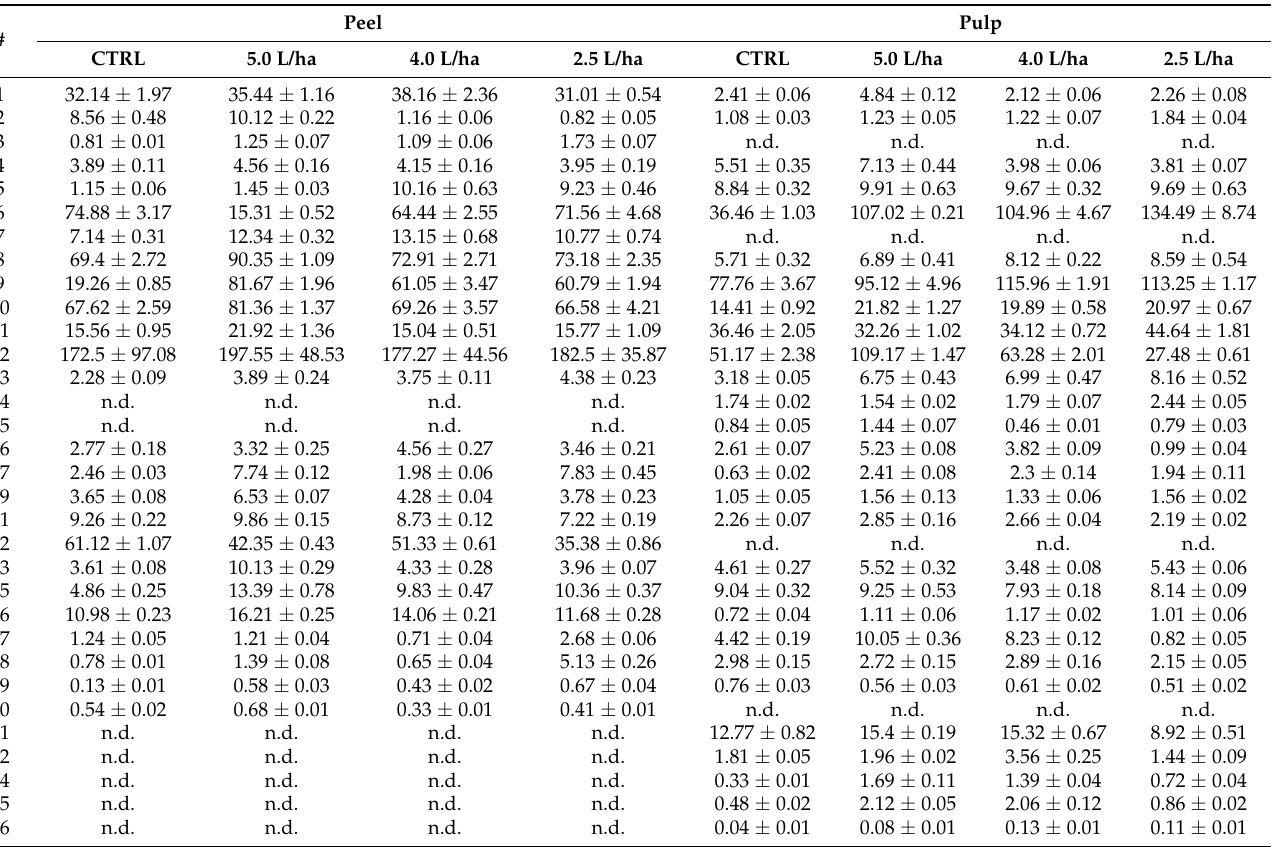
Table 3. Quantitative analysis of polyphenols identified in the fruit peel and pulp of the “West Rose” variety harvested from Prunus persica trees after treatment with three different concentrations of biostimulant (5.0, 4.0 or 2.5 L/ha) or with water alone. In the different panels, CTRL identifies samples harvested from trees treated with water only. Quantification is expressed as the mean ± SD of three experiments conducted in triplicate, and the values are expressed as mg per 100 g fresh weight (FW). The first column reports the identification number of each compound as listed in Table 1 and shown in Figure